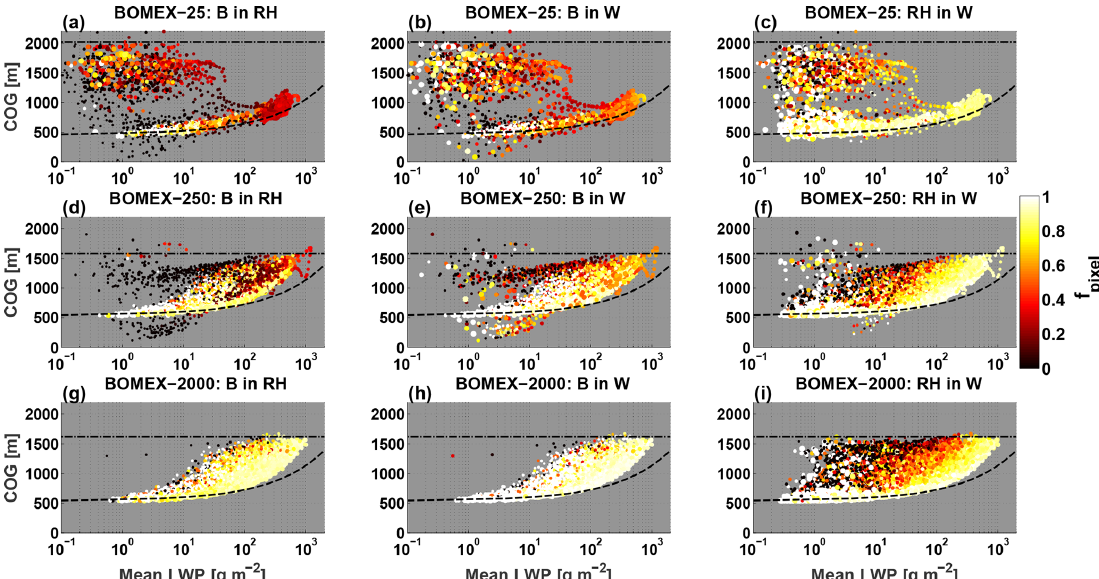
Figure 7. CvM space diagrams showing the pixel fractions ( f pixel ) of B core within RH core (a, d, g) , B core within W core (b, e, h) , and RH core within W core (c, f, i) for the clean (top row, a, b, c ), intermediate (middle row, d, e, f ), and polluted (bottom row, g, h, i ) simulations. Bright colors indicate high-pixel fractions (large overlap between two core types), while dark colors indicate low-pixel fractions (little overlap between two core types). The differences in the scatter density and location for different panels are due to the fact that only clouds which contain a core fraction above zero (for the core in question) are